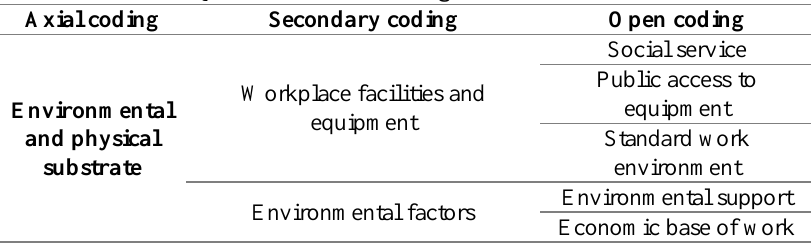
Table 3: Qualitative data coding (contextual conditions)